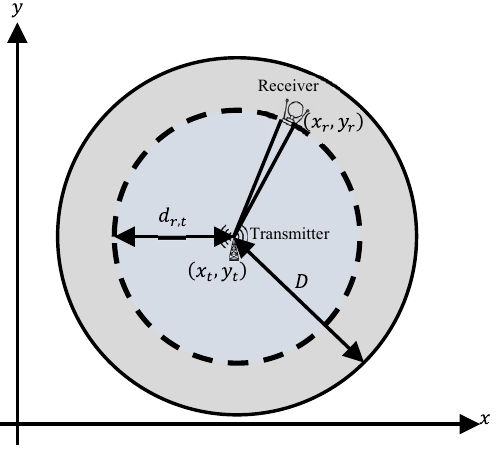
Figure 1. The free-space propagation model in a two-dimensional (2D) design space. Transmitting antenna is modelled as a point source. Transmitted power is spread over the surface area of a hypothetical sphere. The receiver antenna has an aperture. This surface with radius D is called the “free-space coverage pattern for one- way transmission”, see Eq.